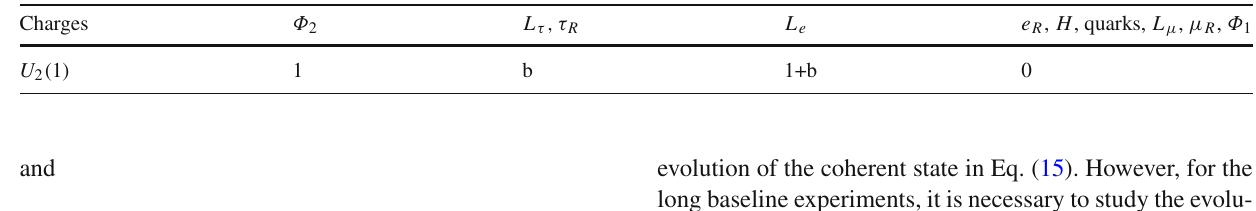
Table 3 The U 2 ( 1 ) charges of the fields. The rest of the fields, including the second generation leptons, Φ 1 , quarks and the Higgs are neutral under